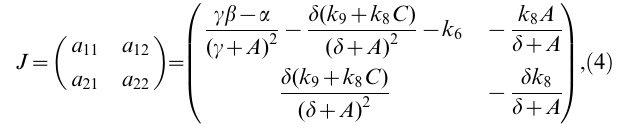
Figure S1 Time evolution of A with and without a low number molecules. Comparison between deterministic simu- lation of the time evolution of A with (dashed line) and without (solid line) a low number of M , R , and C molecules. (Solid line graph: the values of the parameters are as in the section Methods: Biochemical reactions and rates . Dashed line graph: the changed rates